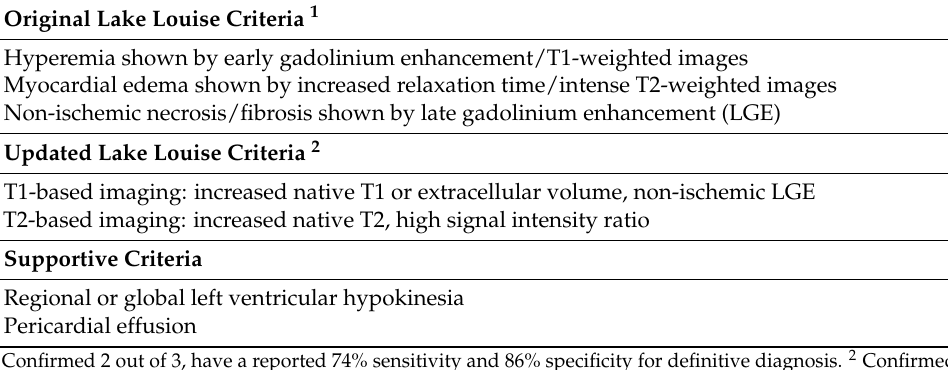
Table 1. Lake Louise criteria for patients with suspected myocarditis